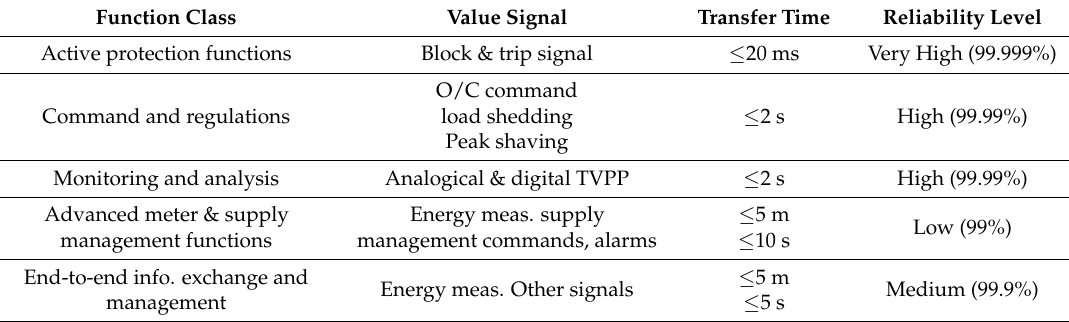
Table 1. Real-time electrical functions